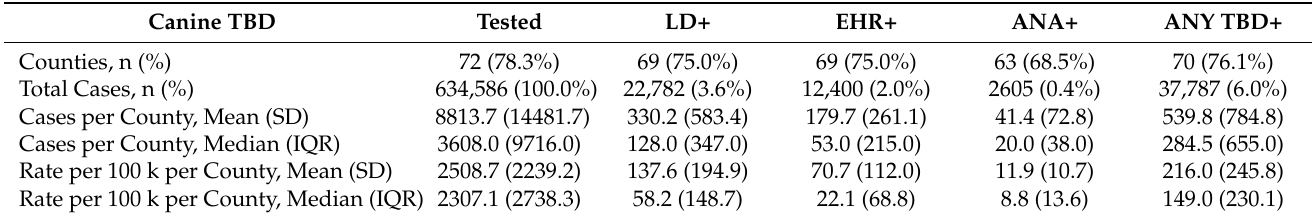
Table 3. Summary statistics of canine TBD frequency across 2017–2020 as reported by the